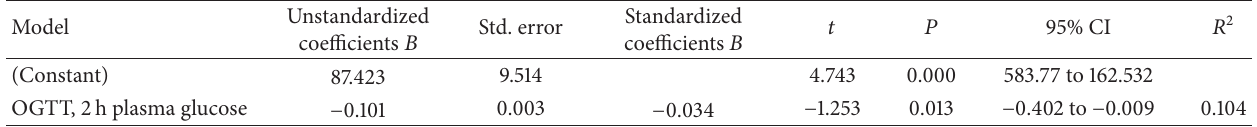
Table 4: Multiple linear regression analyses for HOMA- 𝛽 (stepwise